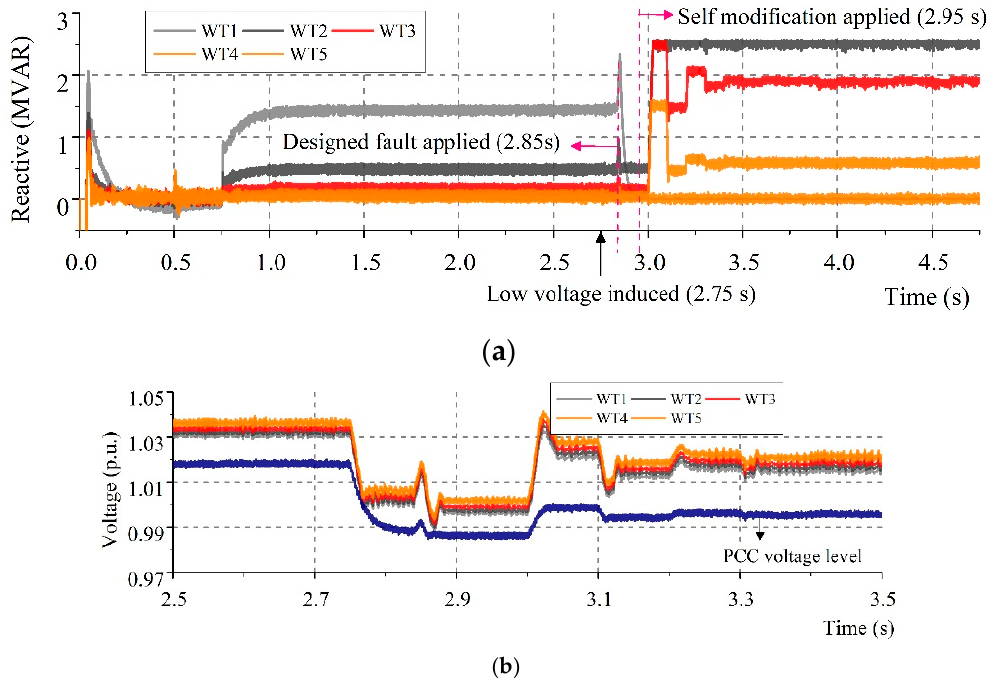
Figure 12. Reactive power supply from array 1 and voltage condition in case C—modified algorithm, with ( a ) reactive power supply, and ( b ) voltage variation.